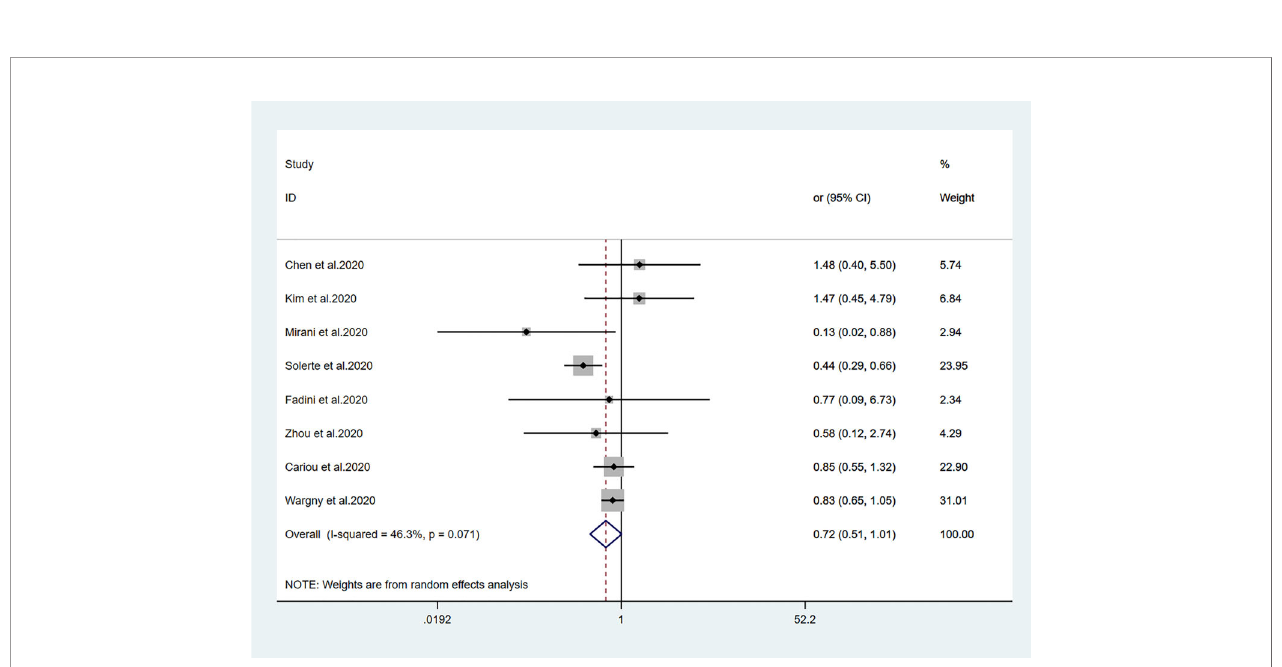
FIGURE 4 | Forest plots of meta-analysis of the relationship between DPP4 inhibitors therapy and the risk of mortality in patients with type 2 diabetes who have